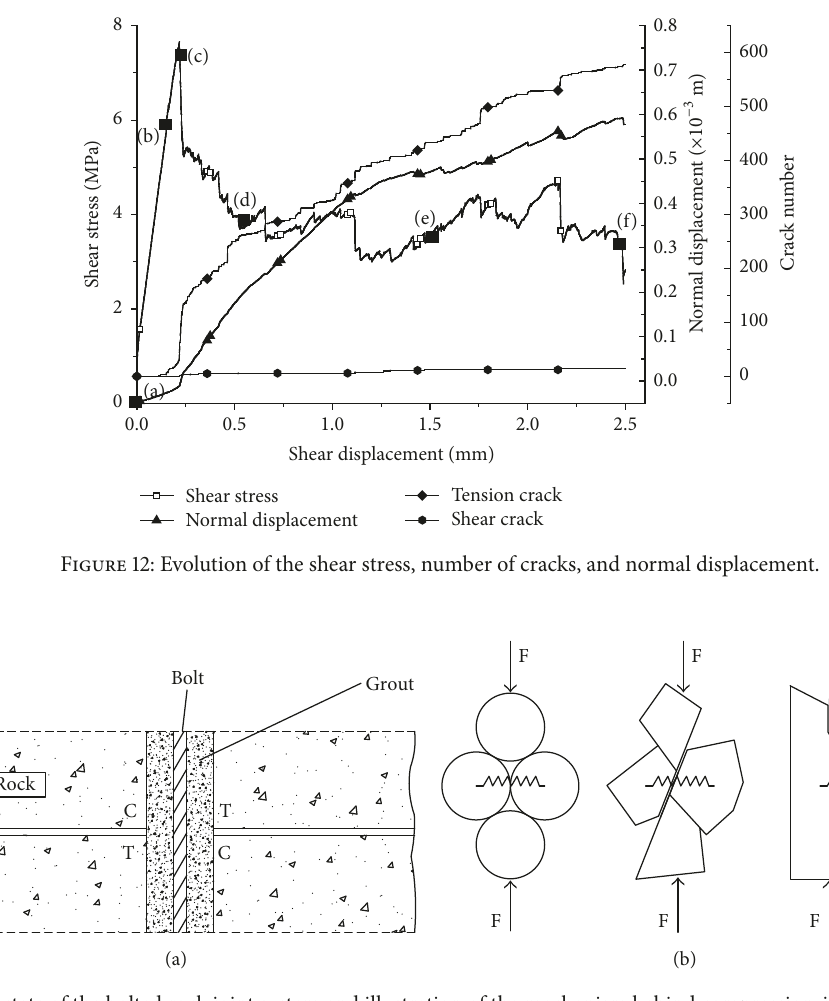
Figure 13: Stress state of the bolted rock joint system and illustration of the mechanism behind compression-induced tension cracks.